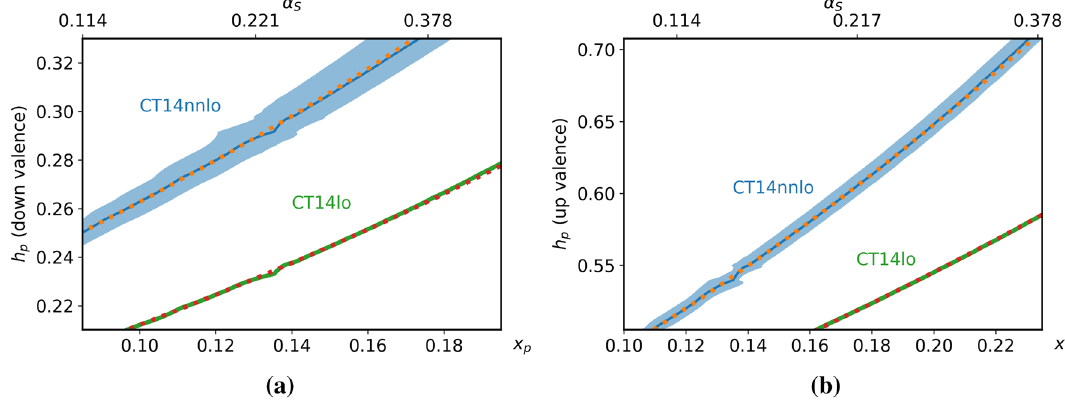
Fig. 5 The peak height and position correlation described by an expo- nential function: h ( x p , t ) = Ce Dx p , from Ref. [39]. CT14lo and CT14nnlo corresponds to the CT14 valence PDF parameterization in leading and next to next to leading order approximation [38]. Other